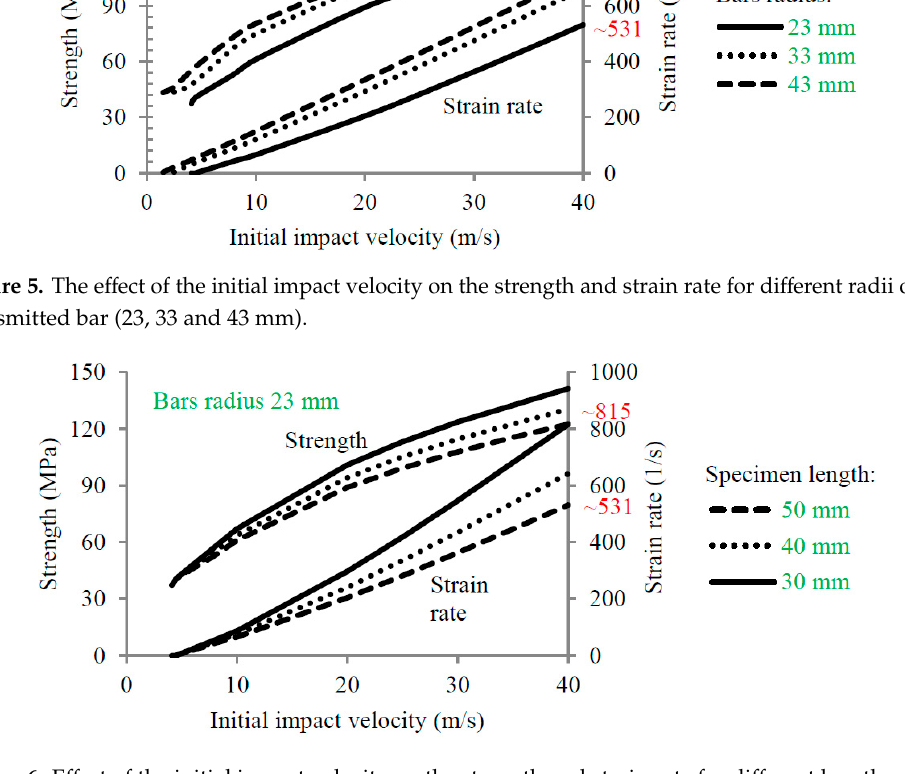
Figure 6. Effect of the initial impact velocity on the strength and strain rate for different lengths of the specimen (50, 40 and 30 mm).